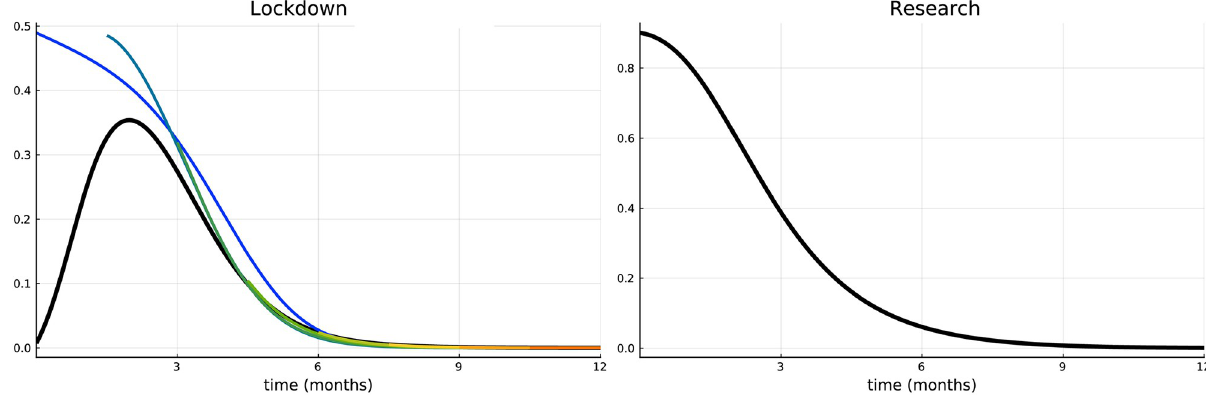
Fig 9. Time dependent lockdown costs. Lockdown intensity over time (left) and research effort over time (right).